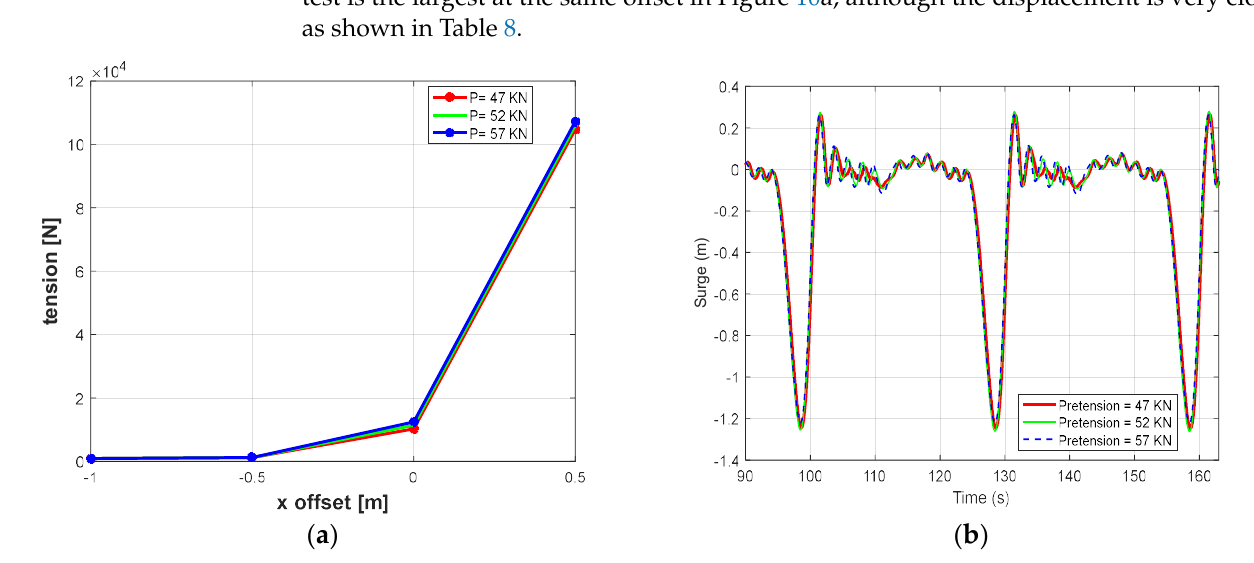
Figure 10. In-plane motions with variations in pretension. ( a ) Stiffness curve, ( b ) surge time series.